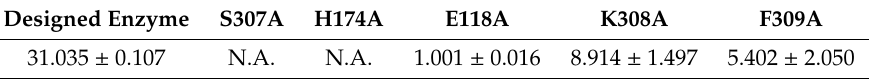
Table 1. Catalytic activity (U / g) determination after alanine mutation of catalytic residues. Designed Enzyme